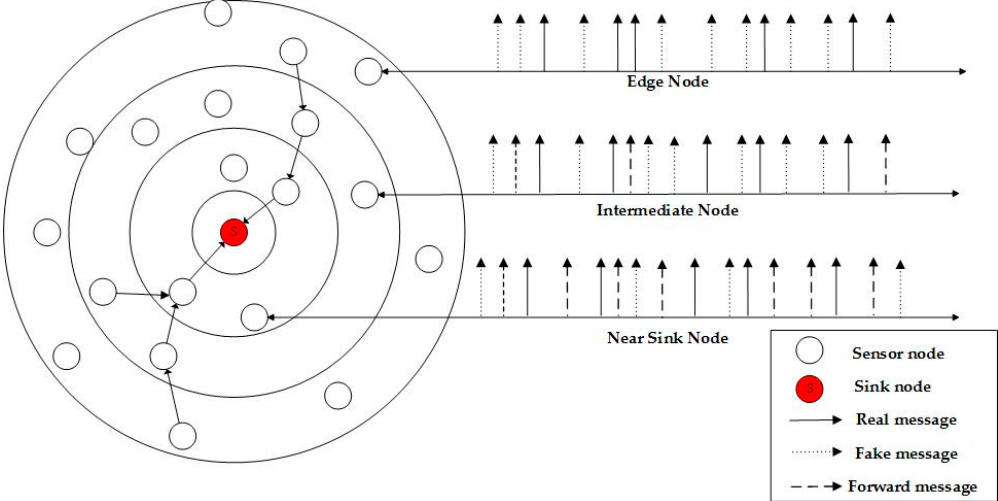
Figure 2. Traffic status of the sensors.